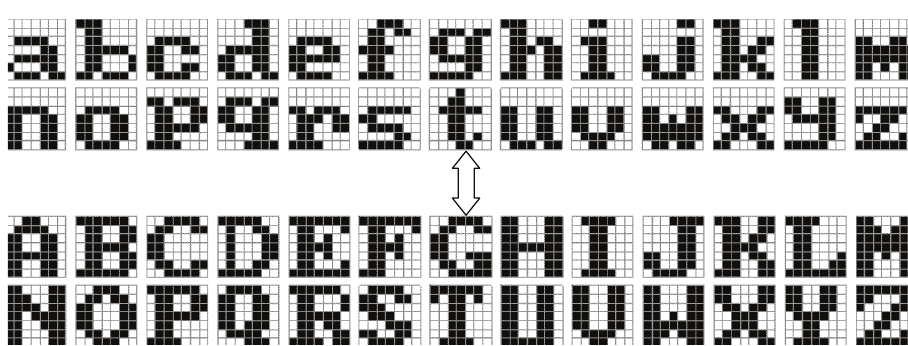
Figure 9: Pattern set used for numerical